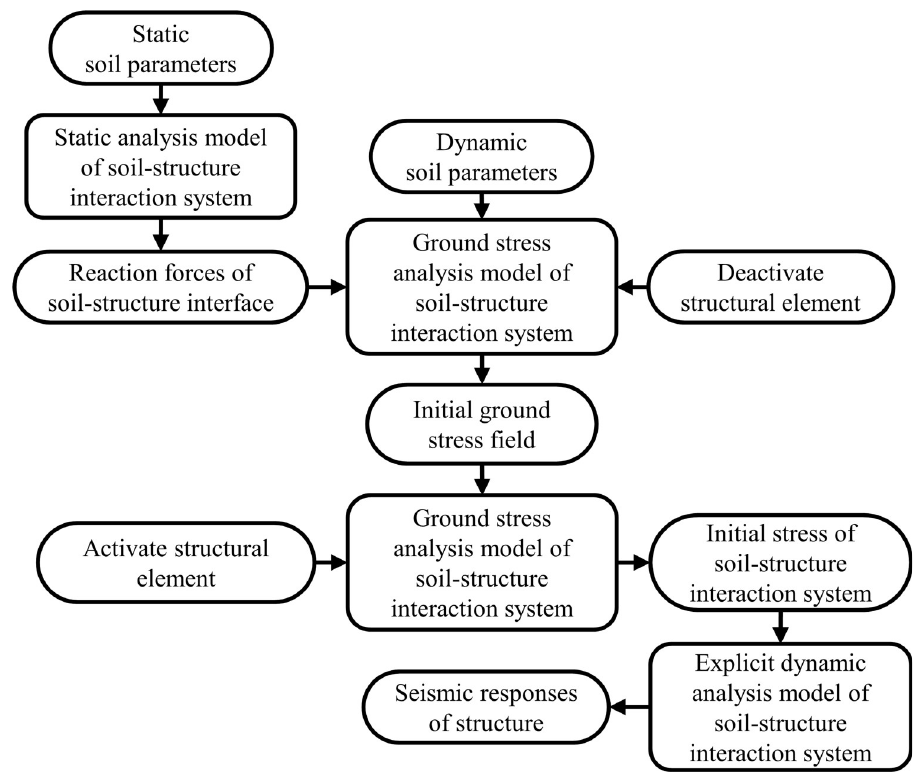
Fig 7. Procedure of the dynamic analysis